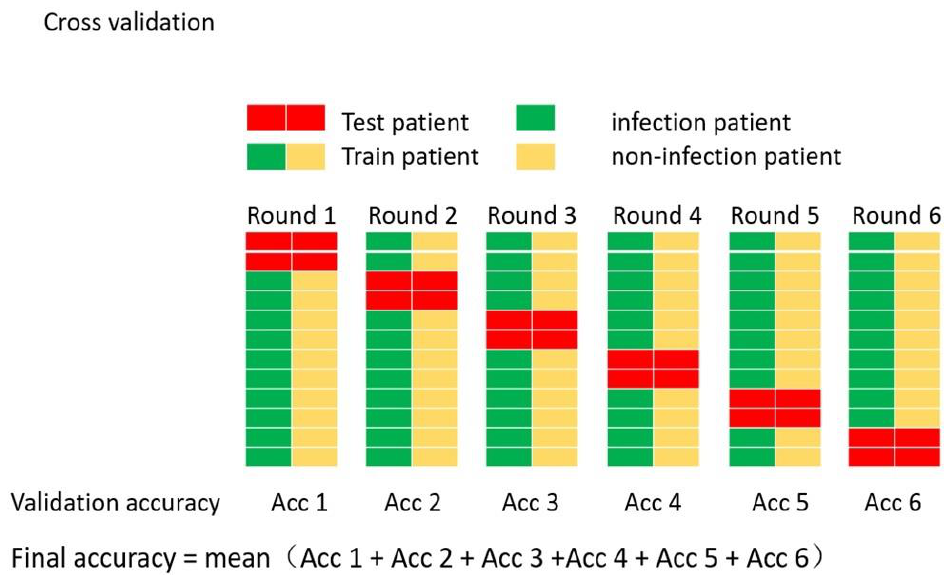
Figure 4. Cross-validating an ENN (ensemble neural networks) model (note: Acc means Figure 4. Cross‐validating an ENN (ensemble neural networks) model ( note: Acc means Accuracy).